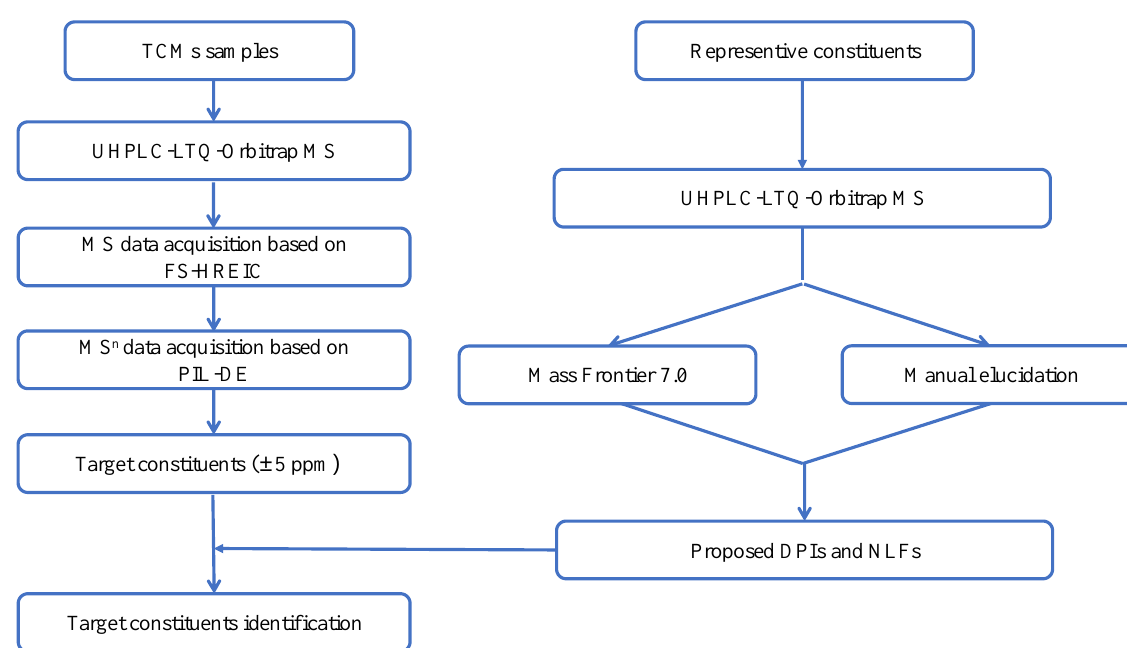
Figure 1. Summary diagram of the presently developed strategy and methodology.